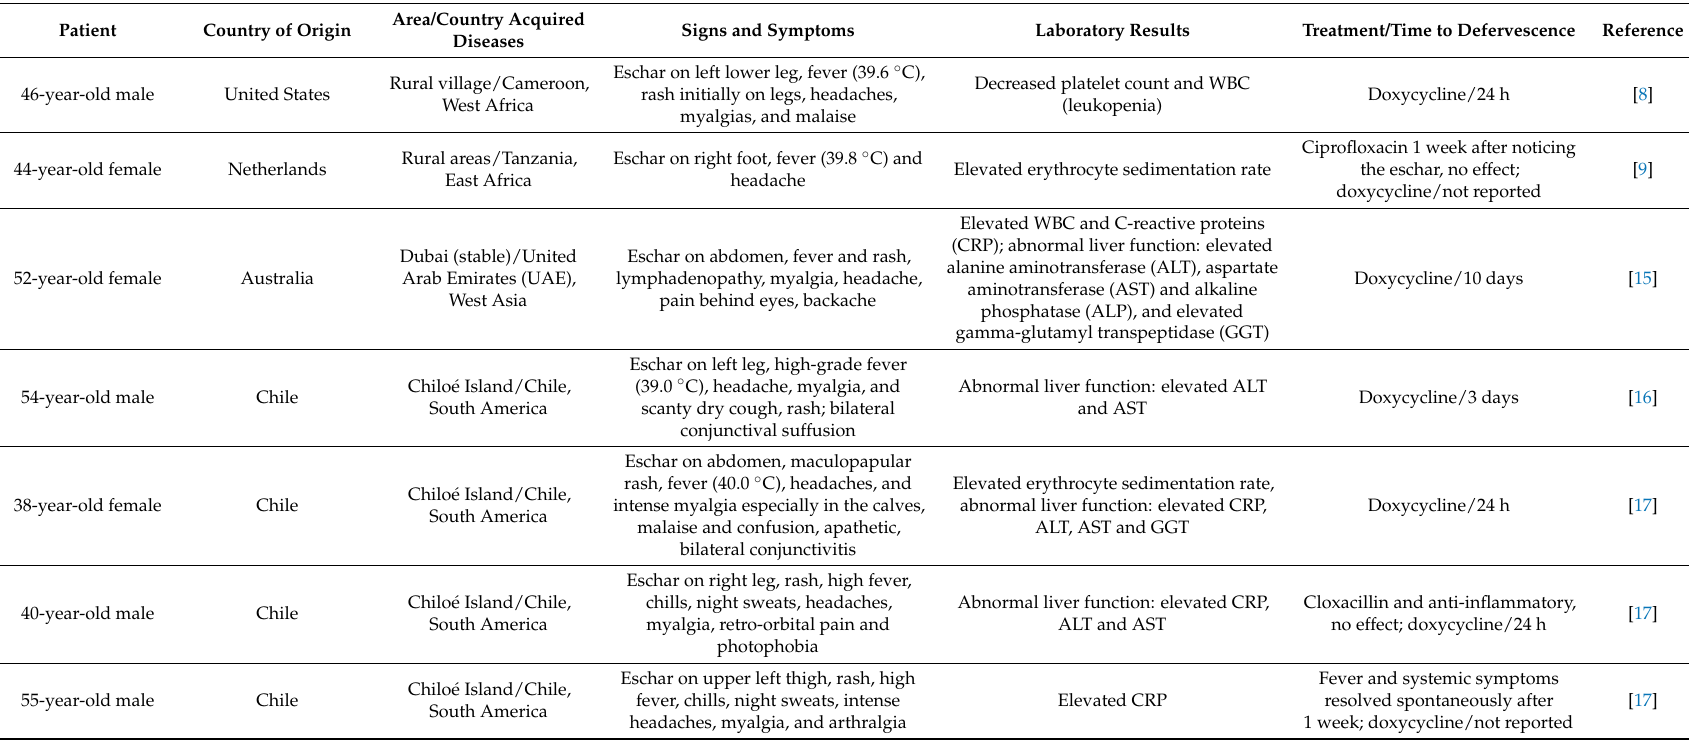
Table 1. Scrub typhus patient presentations outside of the Tsutsugamushi